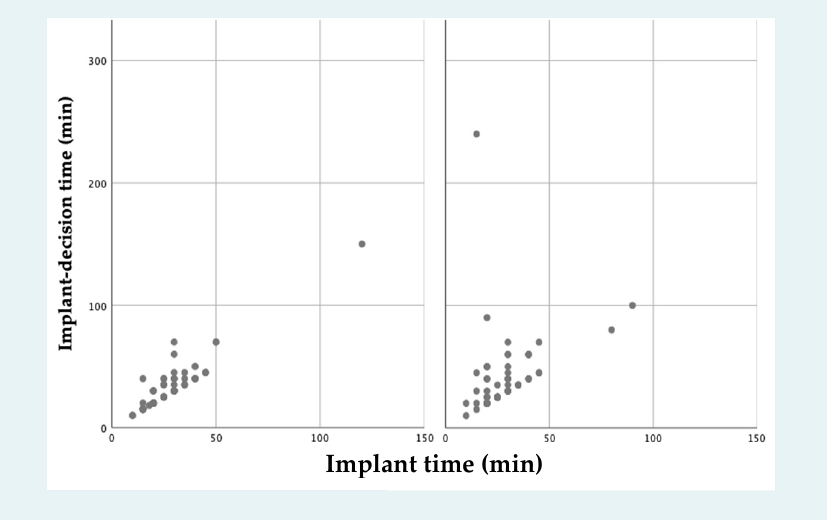
Implant time (min)